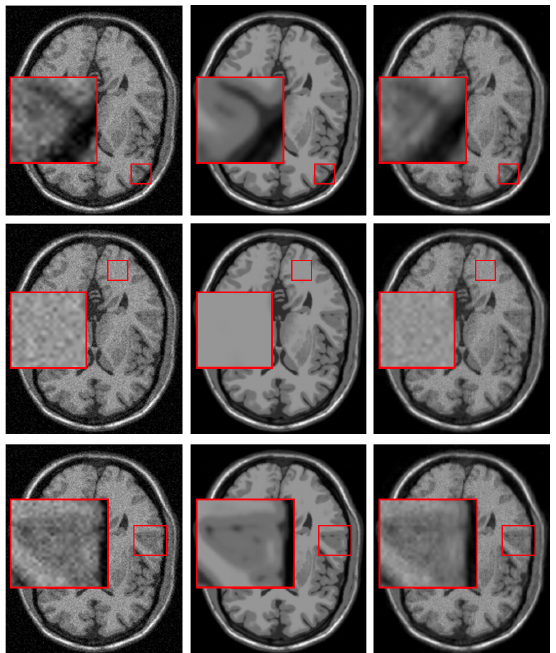
Figure 1. Issues of the KSVD filtering. Columns from left to right correspond to a phantom noise-free image added with 5% Rician noise, original phantom noise-free image, and image denoised by the KSVD. The third column from top to down corresponds to artifacts, residual noise, and blurring issues that the KSVD